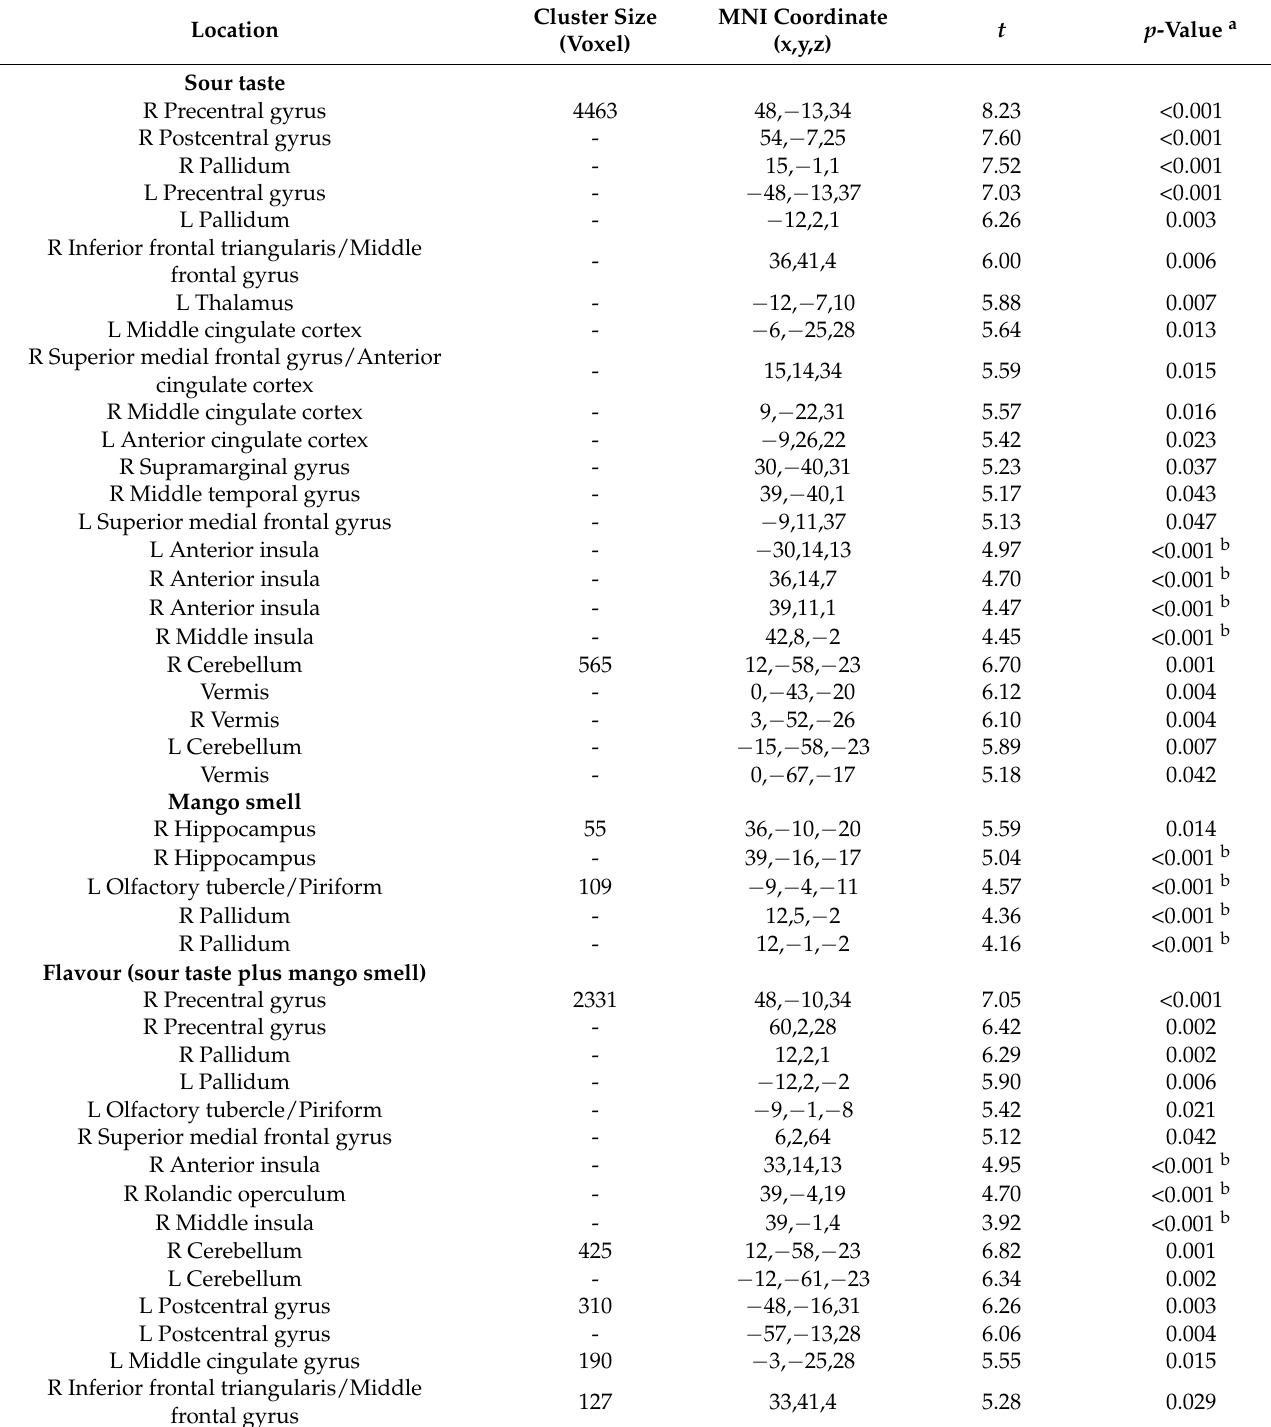
Table 2. Activation peaks from stimulation by taste, smell, and flavour in the group-level whole-brain analysis.